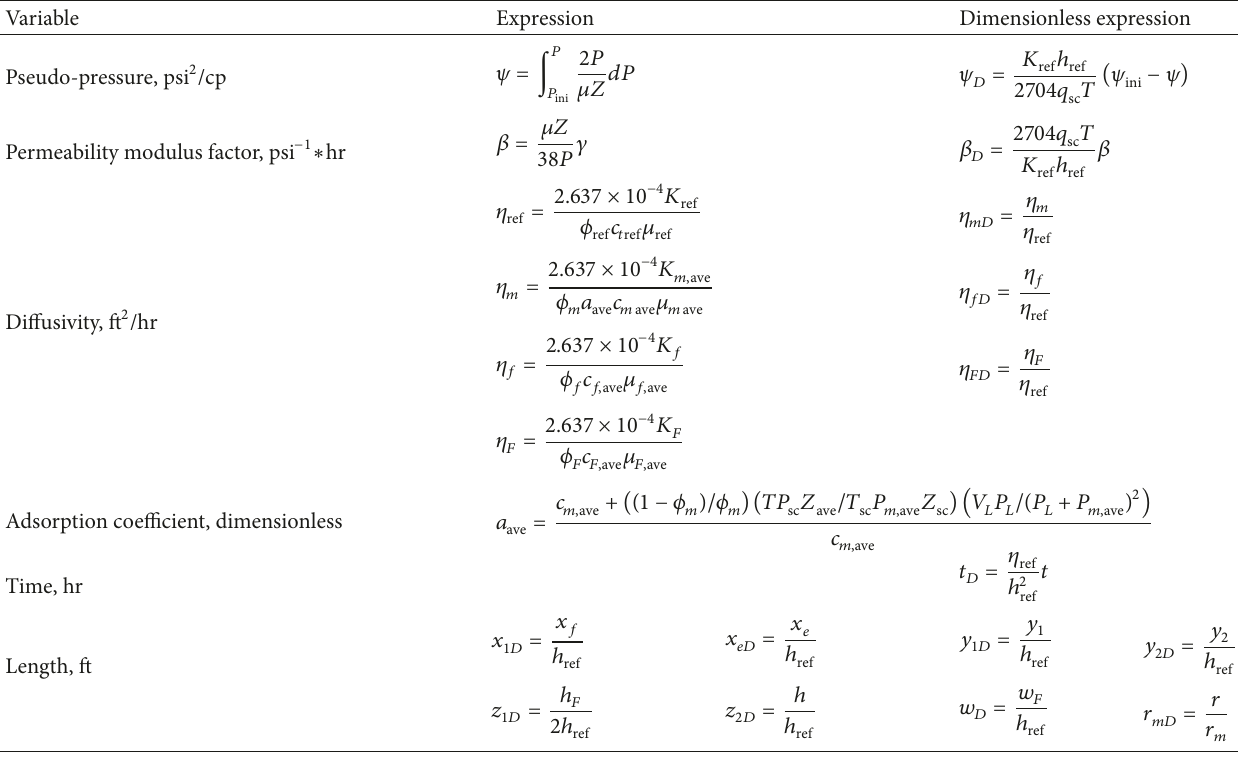
Table 1: Definitions of